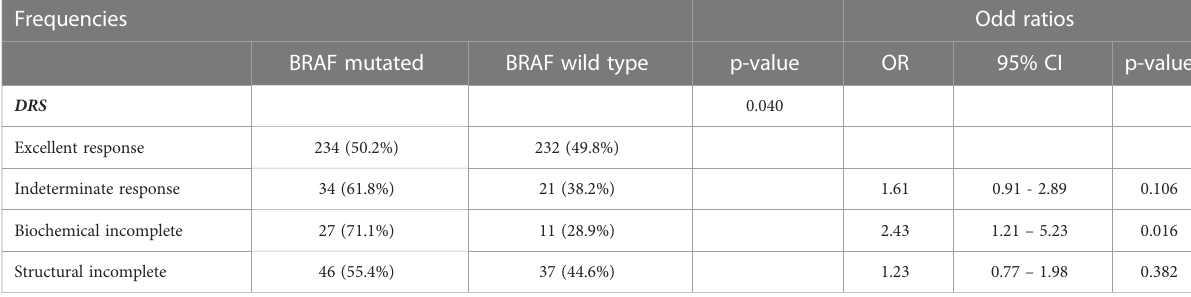
TABLE 6 Impact of BRAFV 6ooE in